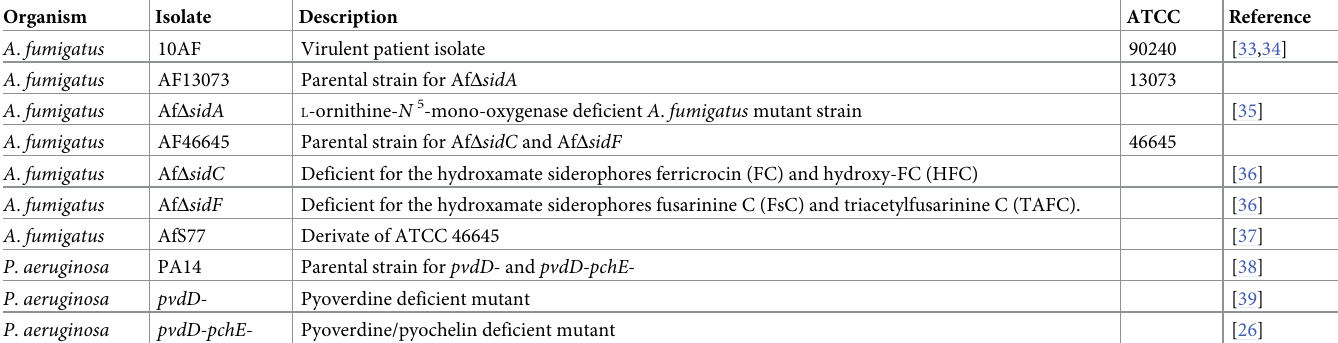
Table 1. Isolates used in this